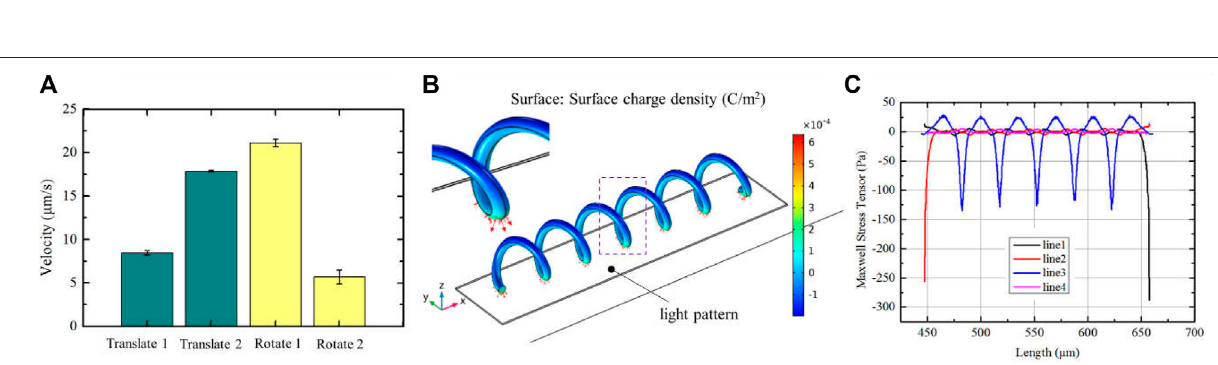
Frontiers in Bioengineering and Biotechnology |